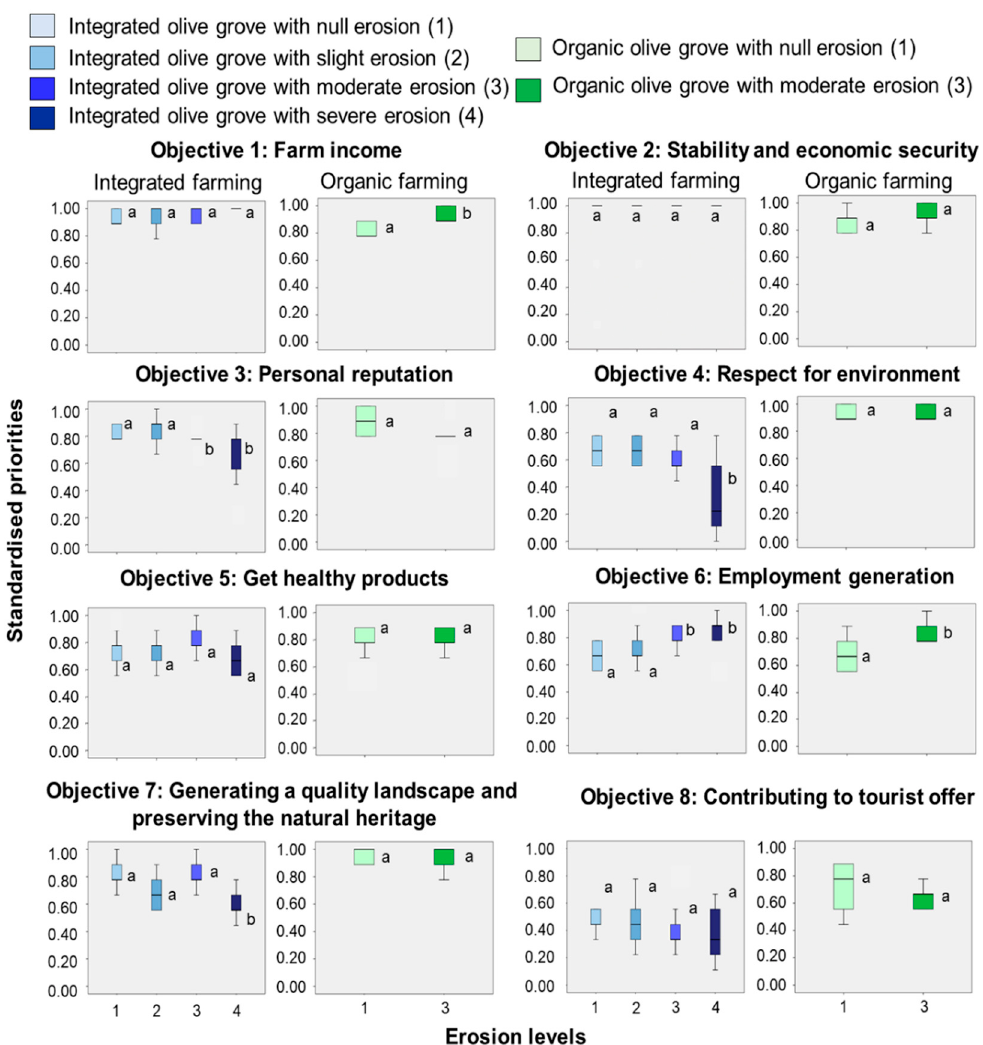
Figure 3. Boxplots showing the results of Tukey’s post-hoc analysis and the Kruskal–Wallis test for each objective evaluated in the integrated and organic olive groves according to their erosion levels. The letters inside each boxplot indicate the classification groups generated to establish similar categories to each objective.